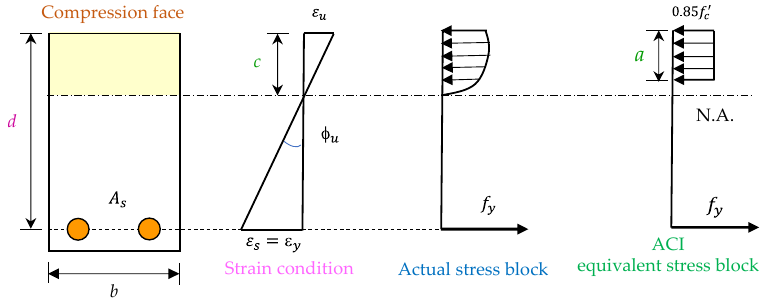
Figure 23. The stress and strain profiles of a typical reinforced concrete beam at the ultimate state.